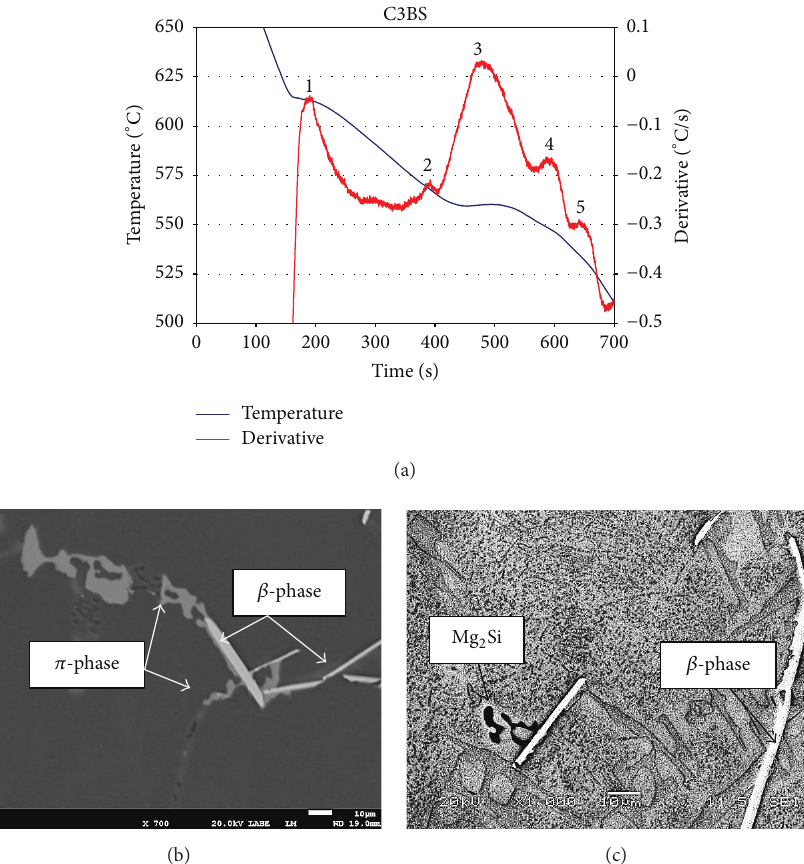
Figure 3: (a) Temperature-time cooling curve and its first derivative obtained from the alloy C3BS, (b) the corresponding microstructure showing much bigger size of the 𝛽 -Al 5 FeSi phase and the 𝜋 -phase particles, and (c) the corresponding microstructure showing much larger size of the 𝛽 -phase and the Mg 2 Si particles.